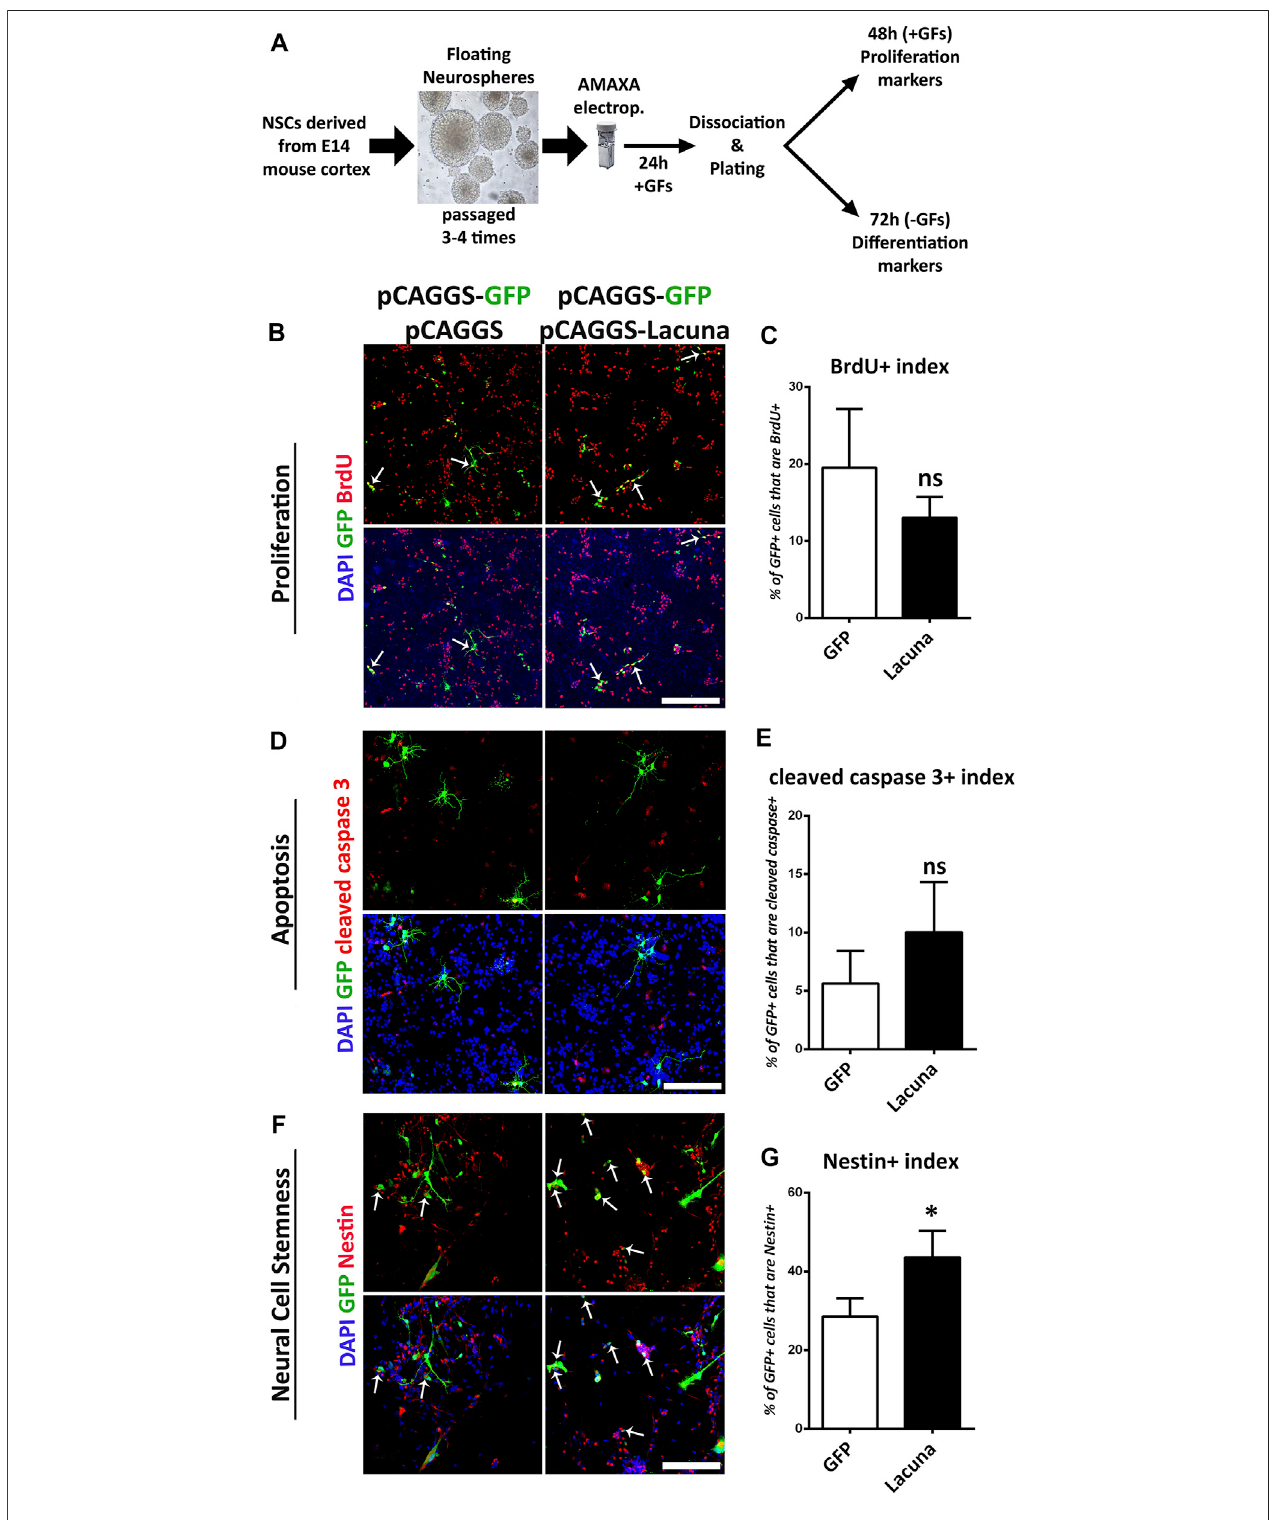
FIGURE 2 | Lacuna overexpression affects stemness but not proliferation nor apoptosis of mouse Neural Stem Cells. (A) Schematic representation of our experimental strategy. NSCs are derived from E14 mouse cortices and they are cultured appropriately to form neurospheres over 3 – 4 passages. Neurospheres are transfectedwithplasmidsofchoiceandthen, theyaredissociated andplated. Inthepresenceofgrowth factors, NSCsproliferate,whereaswithoutgrowth factors,they